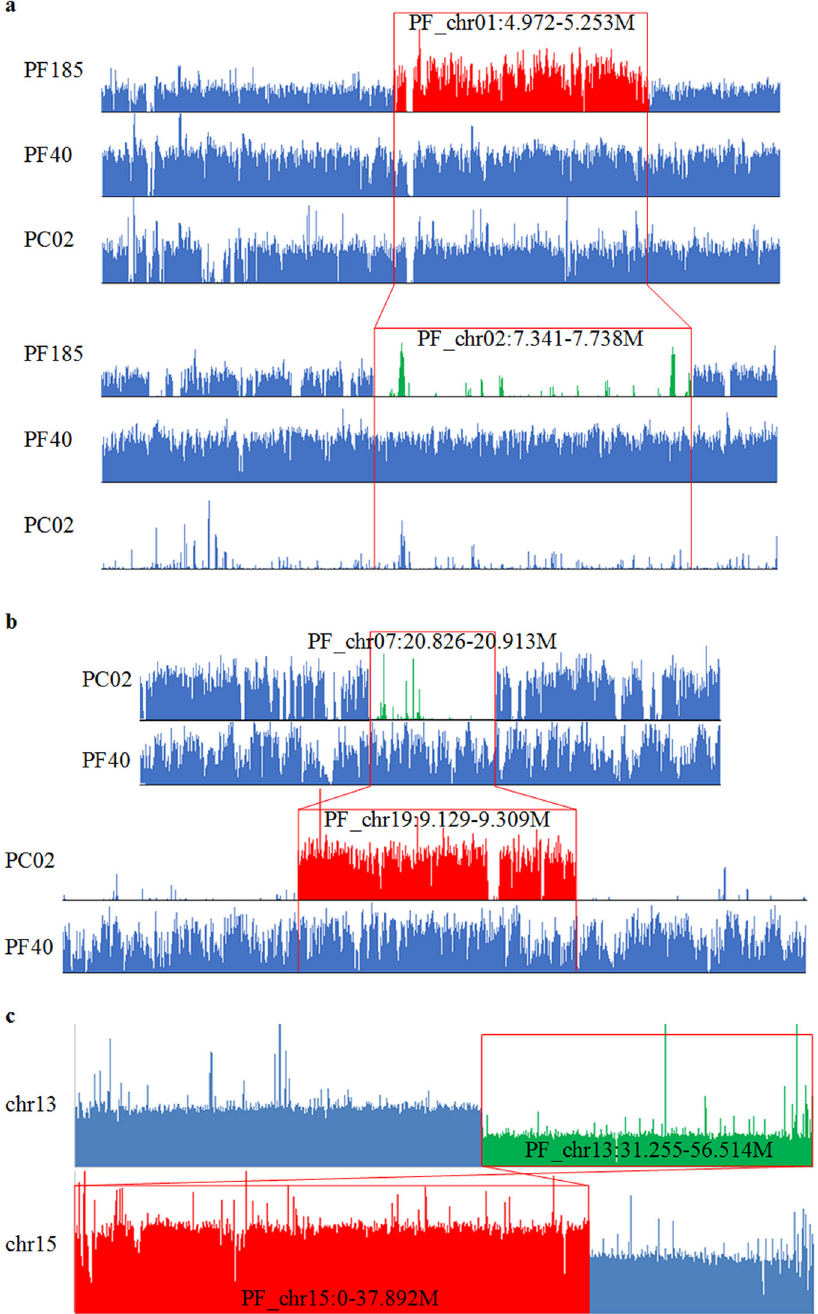
Fig. 3 Patterns of subgenome exchanges in the allotetraploid. a Sequencing depth distribution between syntenic subgenomes indicated homeologous exchange in PF185. Coverage by PC02 indicated that the chr1 block was of AA-origin. In PF185, a 397-kb segment of chr2 (deletion, shown in green) was replaced by 281-kb homeologous sequences of chr1, resulting in a seemingly duplication of the chr1 segment (in red). Red boxes marked the corresponding HE intervals. b Reciprocal HE swapped 180 kb of chr7 with its syntenic chr19 interval. This balanced exchange was inherited by all tetraploid accessions. c Replacement of chr13 segments by non-homeologous chr15 sequences resulted in gene dosage imbalance (1:3) in